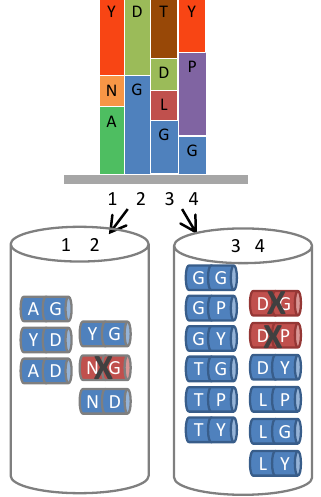
Figure 4. Removal of liabilities from hexameric ProxiMAX. A hypothetical gene region requiring 4 positions of saturation mutagenesis (1 to 4, top diagram), each position having varying codon number, identity and frequency, can be fabricated by automated hexameric ProxiMAX by sequential addition of two pools of MAXMAX codons (1–2 and 3–4, bottom diagram) containing the required mixture of double-codons at a defined percentage, dictated by the specific library design. Any unfavorable codon pair can be selectively removed from the mixes, increasing the functionality of the